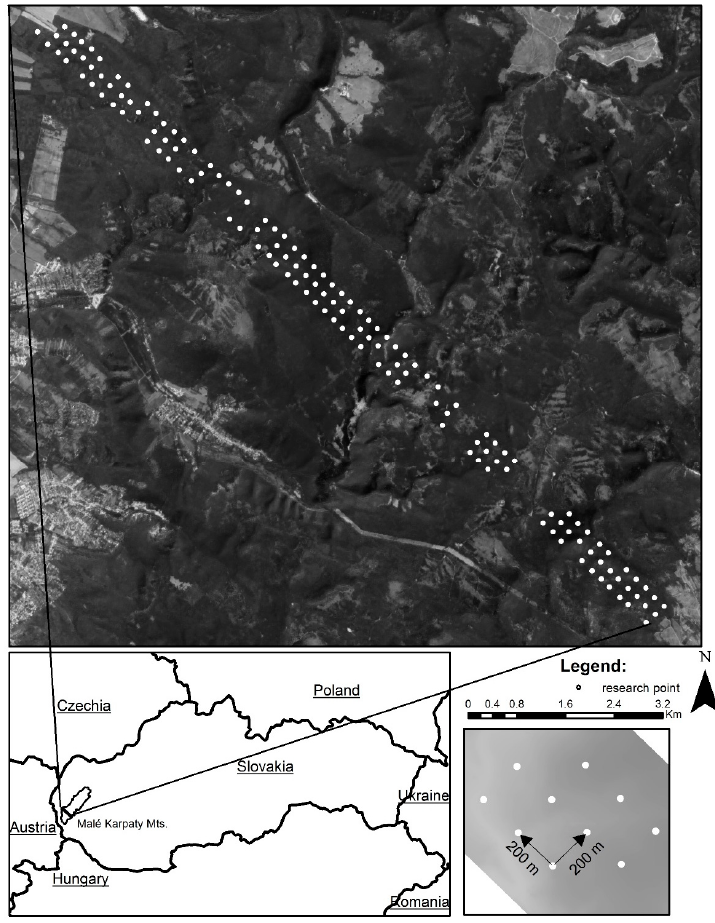
Figure 1. Location of the study areas and detailed view of selected study plot.